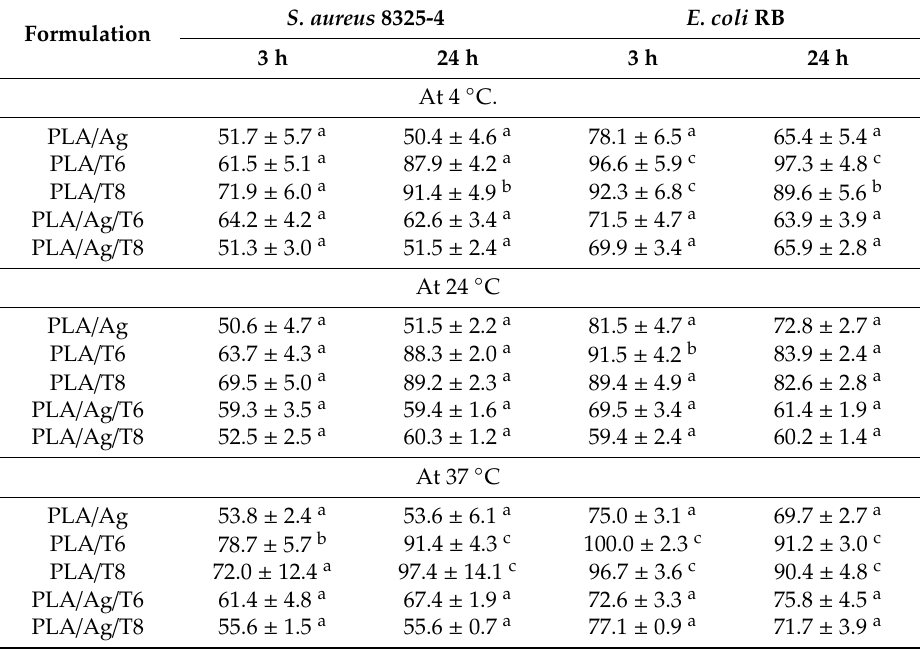
Table 5. Antibacterial activity of neat PLA and nanocomposite films, expressed as cell viability (%), against S. aureus 8325-4 and E. coli RB strains after 3 and 24 h of incubation at 4, 24, and 37 ◦ C. Mean ± SD (n =